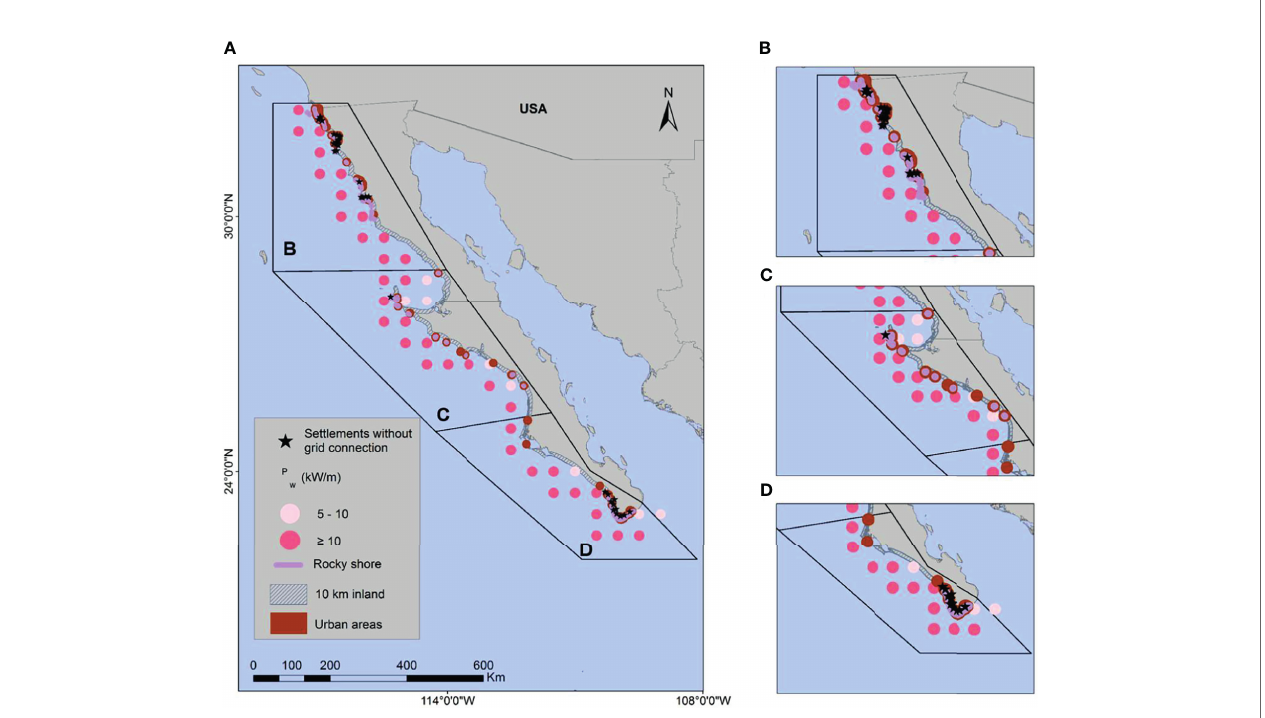
FIGURE 8 | Spatial conjunction of selected variables with potential interest for decision makers. (A) for all the peninsula, (B) for the northern, (C) the central, and (D) the southern part of the peninsula.